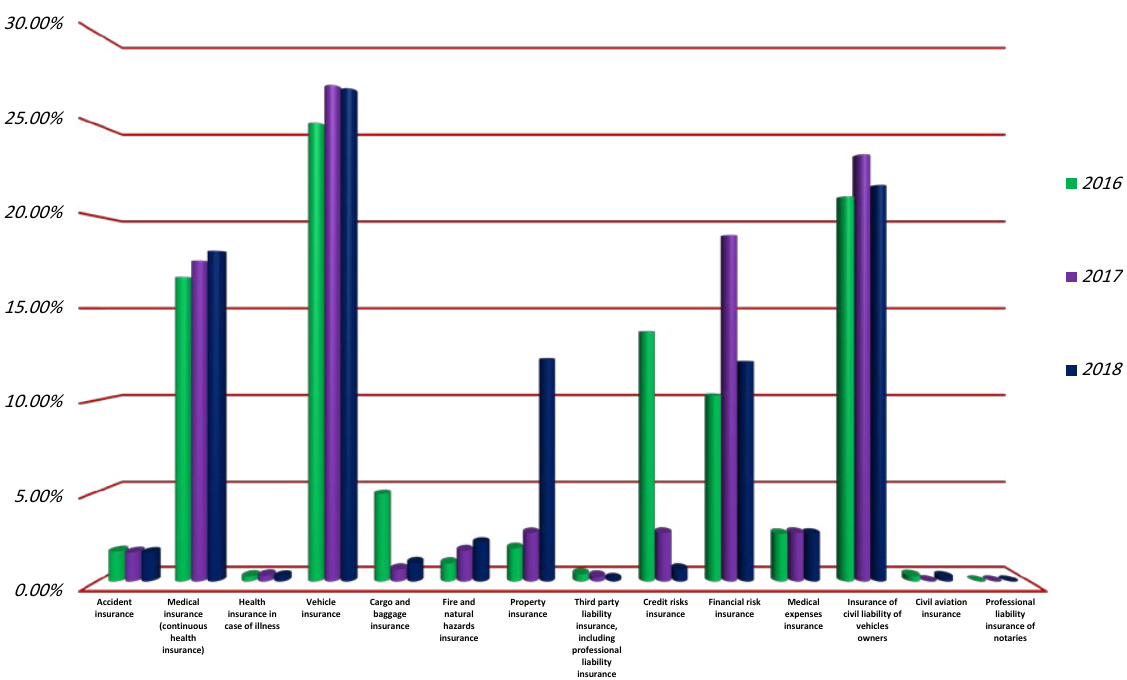
Fig. 2: Dynamics of insurance reimbursement under various types of insurance during 2016-2018 in Ukraine